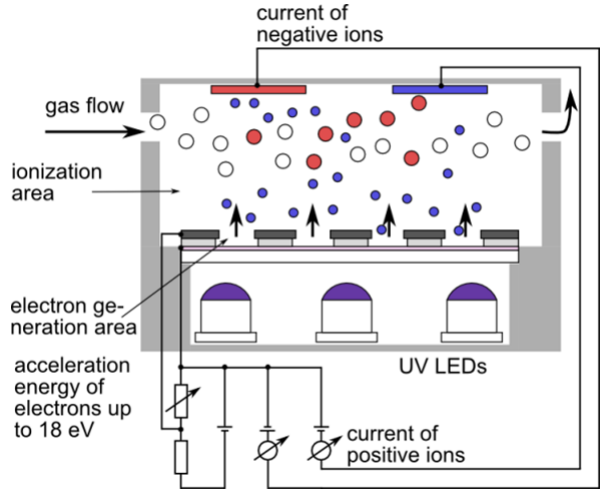
Figure 2. Basic principle of an electronic supported photoioniza- tion detector (ePID; Zimmer et al.,